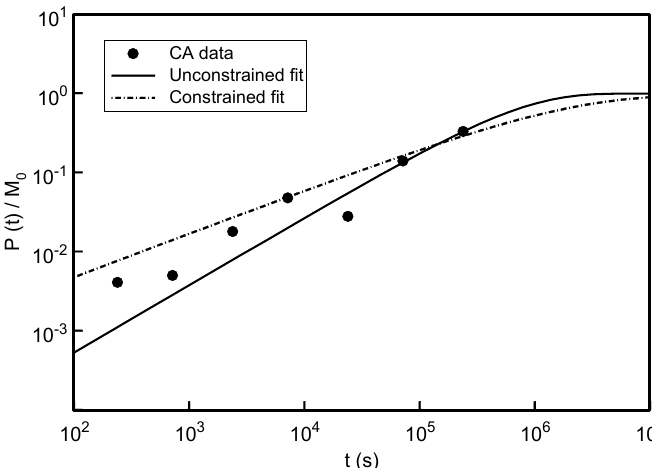
Figure 7. Dynamical dependence of indazole (IND) photo ‐ product creation (symbols) determined for a series of MDP samples doped with p ‐ diethylaminobenzaldehyde ‐ 1,1 ʹ‐ diphenylhydrazone (DEH). The fitted lines are discussed in the text.